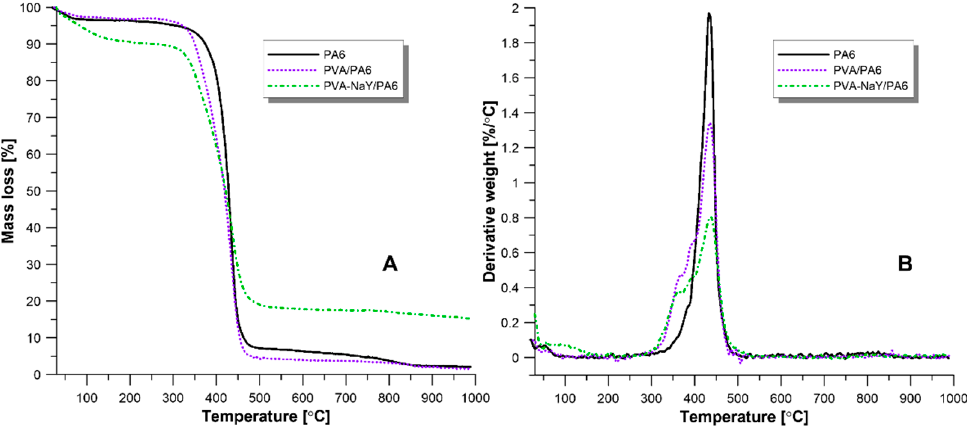
Figure 9. TGA ( A ) and DTG ( B ) curves of PA6 support, PVA/PA6 and PVA-NaY/PA6 composite